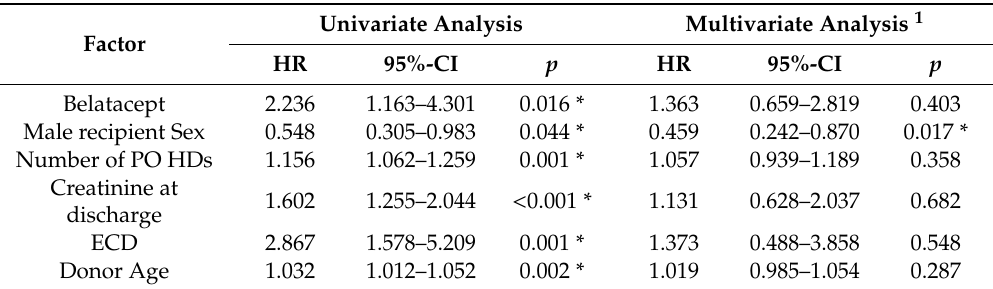
Table 6. Cox regression for severe infection. All the significant risk factors from the univariate Cox-Regression are shown and were included in the multivariate analysis. p -values < 0.05 are marked with an asterisk